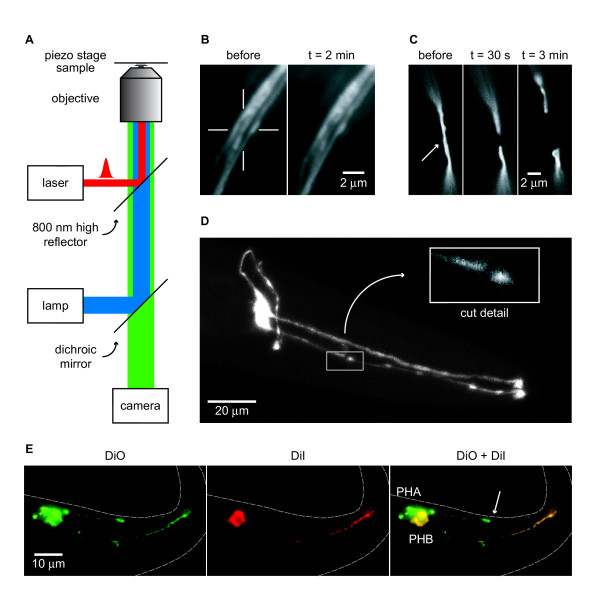
Femtosecond laser ablation. A. Diagram of laser surgery setup. Amplified femtosecond laser pulses are tightly focused by an objective lens (1.4 NA) to dissect targets positioned with a three-dimensional piezoelectric stage and visualized by fluorescence microscopy. B. DiO-stained amphid dendrites before and after severing the middle dendrite using 3-nJ pulses without visibly affecting neighboring dendrites as close as 500 nm away. C. An example of a GFP-labeled AFD dendrite retracting after surgery using 6-nJ pulses. D. Confocal microscope image showing GFP-labeled AFD neurons the day after surgically severing one dendrite. The position of the cut along the dendrite is representative of all experiments. E. Phasmid DiO (pre-surgery) and DiI (post-surgery) staining 24 hours after surgery of the PHA dendrite. The PHA cell body does not absorb DiI because it is physically disconnected from its sensory endings. The cut in the dendrite is indicated with the arrow.